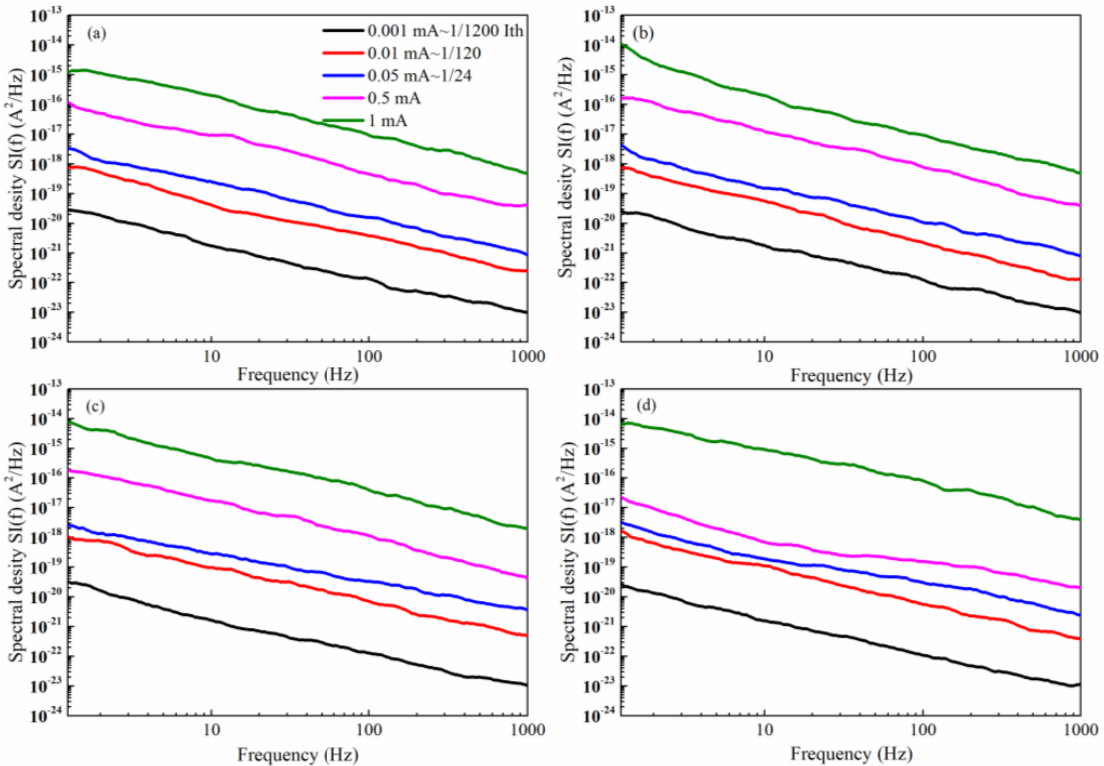
Figure 7. The current noise power spectral density curves versus frequency at different bias currents. Accelerated aging was carried out under current stresses of ( a ) 12 mA, ( b ) 15 mA, ( c ) 17 mA and ( d ) 20 mA, respectively.